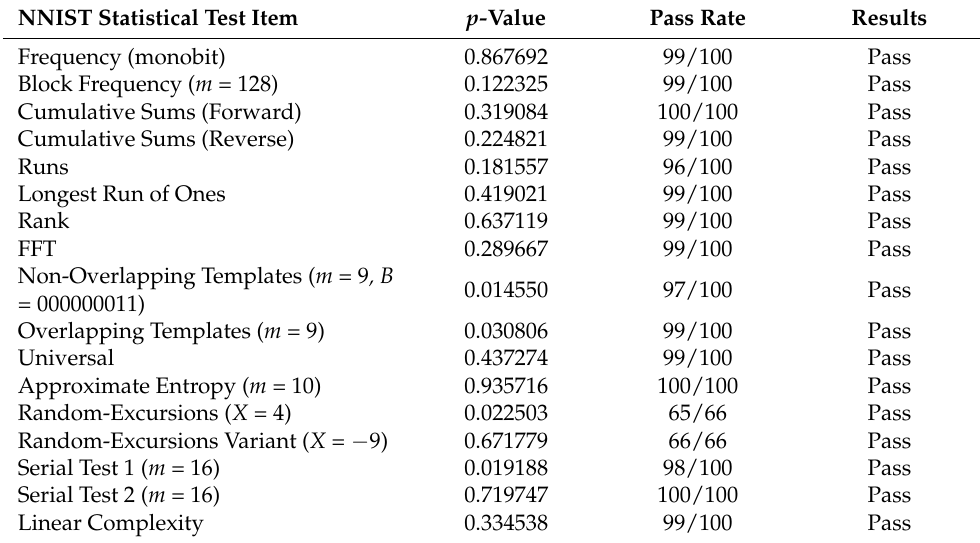
Table 1. NIST statistical test results for the generated chaotic